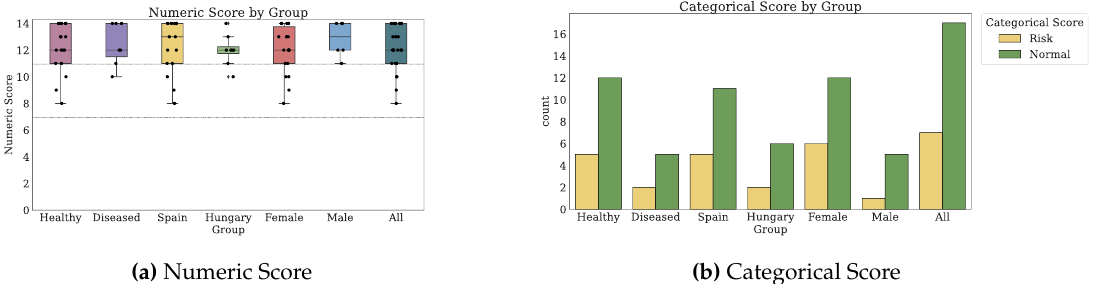
Figure A7. Scores for Nutrition (SelfMNA). Dotted markings delimit levels of the categorical score.